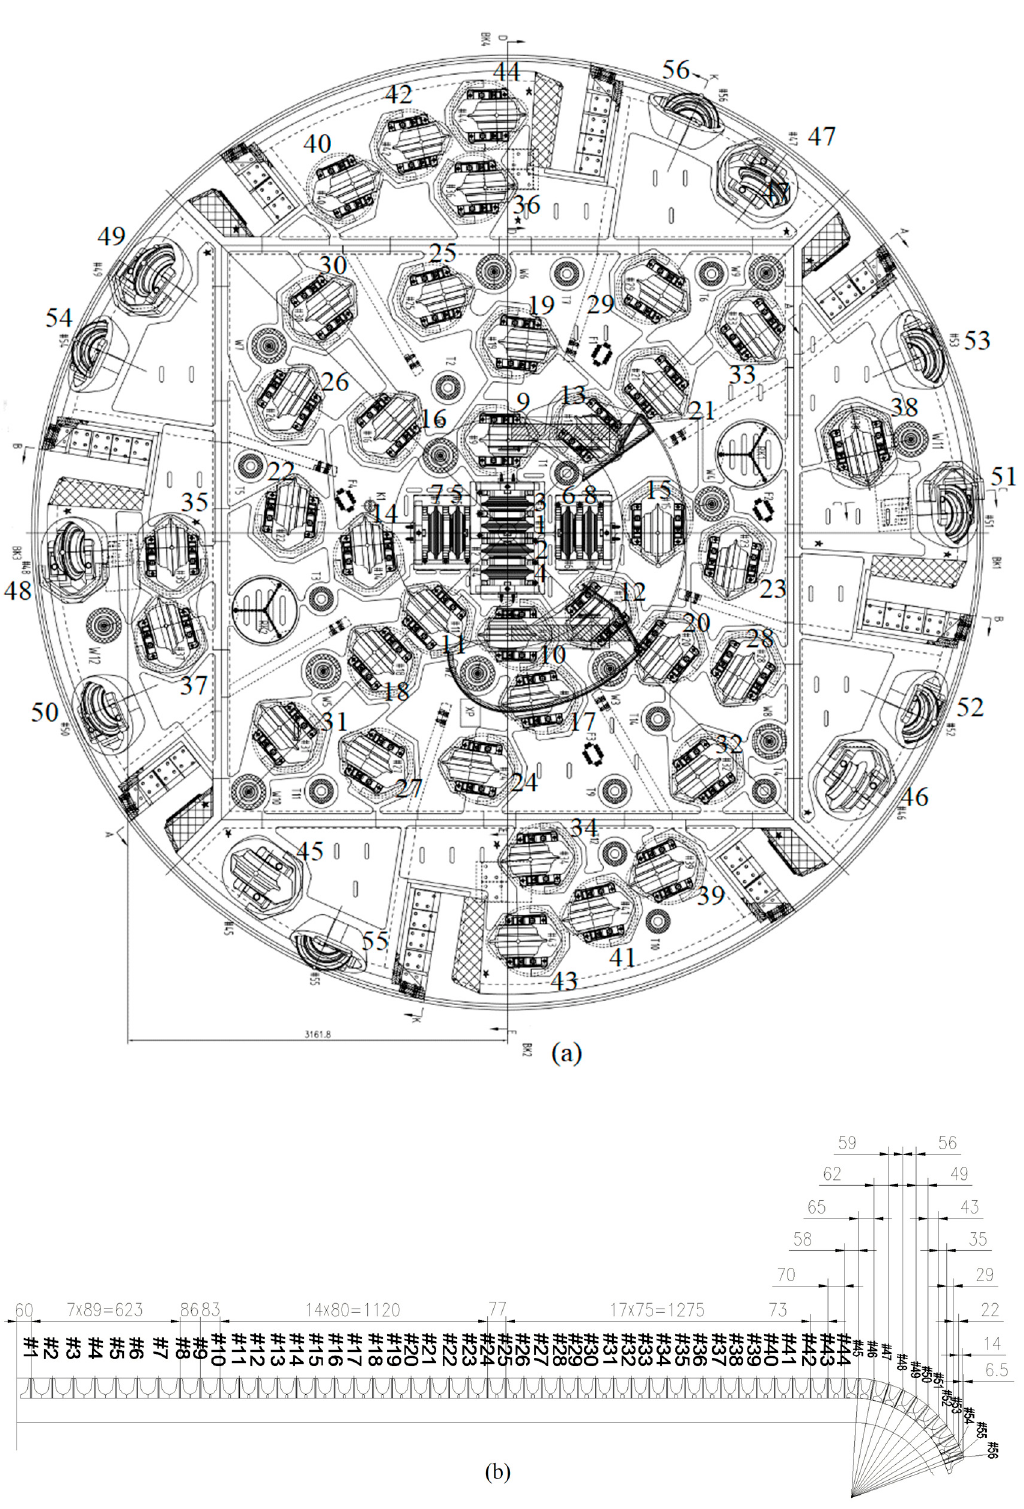
Figure 4. ( a ) Structure of the TBM cutterhead; ( b ) Schematic diagram of the cutterhead.